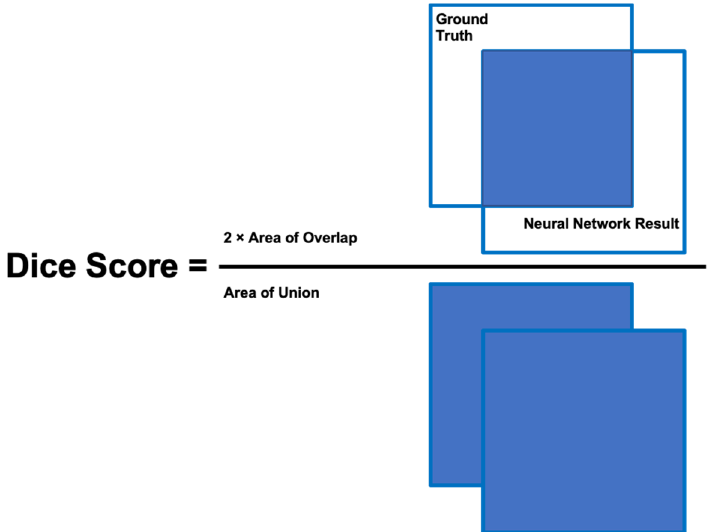
Figure A1. The Dice score is used to measure the performance of the neural network. Its range is from 0 (worst) to 1 (best). A score of 1 demonstrates perfect overlap between the ground truth and the neural network’s output. A score of 0 shows that the ground truth and neural network’s output have no intersection.